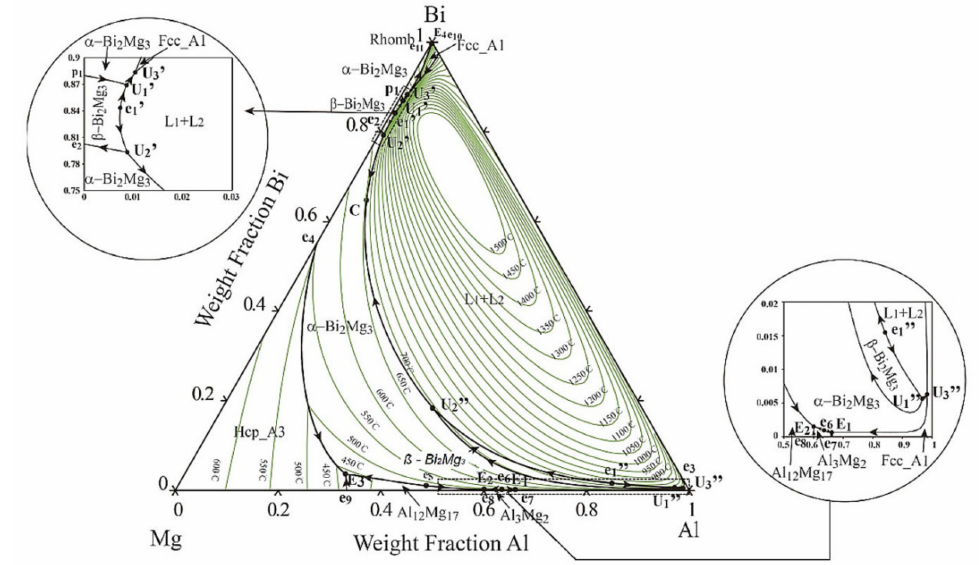
Figure 8. Al-Mg-Bi ternary phase diagram